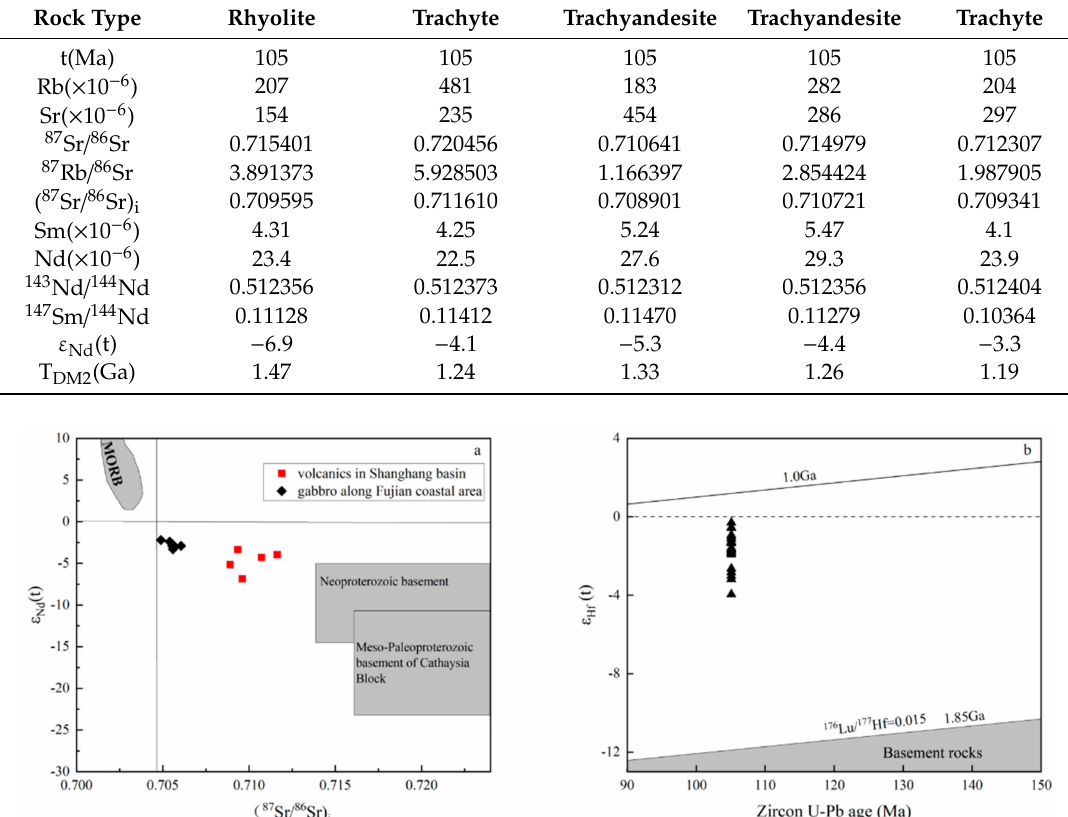
Figure 9. ( a ) Whole rock ε Nd (t) versus ( 87 Sr / 86 Sr) i diagram for the volcanic rocks from the Shanghang Basin. The fields are from [56,57]. Data for Cretaceous gabbro from the coastal area in Fujian are from [55]. ( b ) Zircon ε Hf (t) versus U–Pb age diagram for the volcanic rocks from the Shanghang Basin. The gray field represents Cathaysia basement rocks, data are from